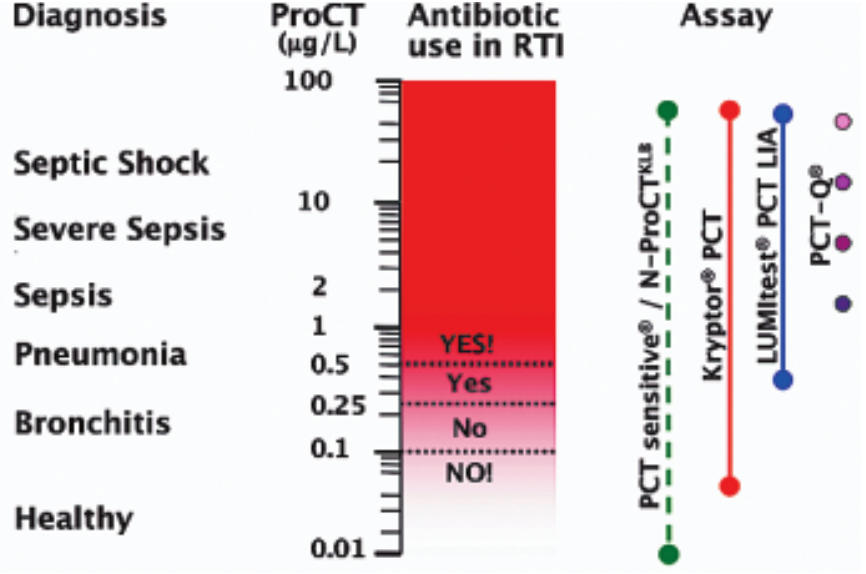
The importance of the procalcitonin (ProCT) assay used. The cut-offs for antibiotic use in respiratory tract infections (RTI) were validated in intervention trials. Importantly, these cut-off ranges are dependent on the clinical context and have to be adapted accordingly (eg lower cut-off ranges with markedly impaired pulmonary reserve, higher cut-off ranges in patients with systemic inflammatory response syndrome on an intensive care